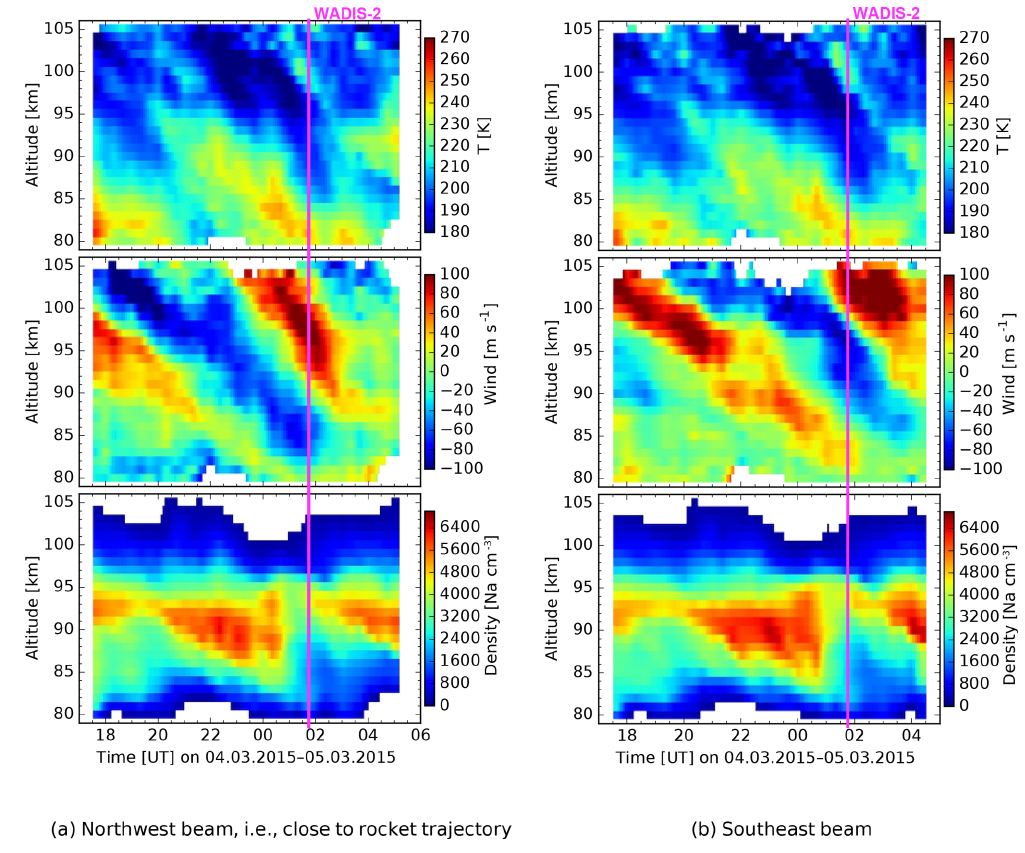
Figure 5. Na lidar measurements during the night of the WADIS-2 rocket launch, i.e., 4 to 5 March 2015. The rocket was launched at